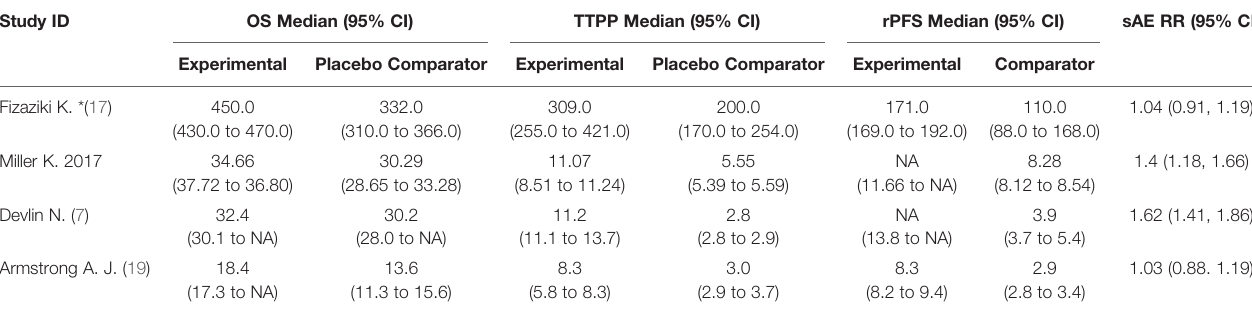
TABLE 2 | Indirect comparative results of abiraterone acetate and enzalutamide. Study ID